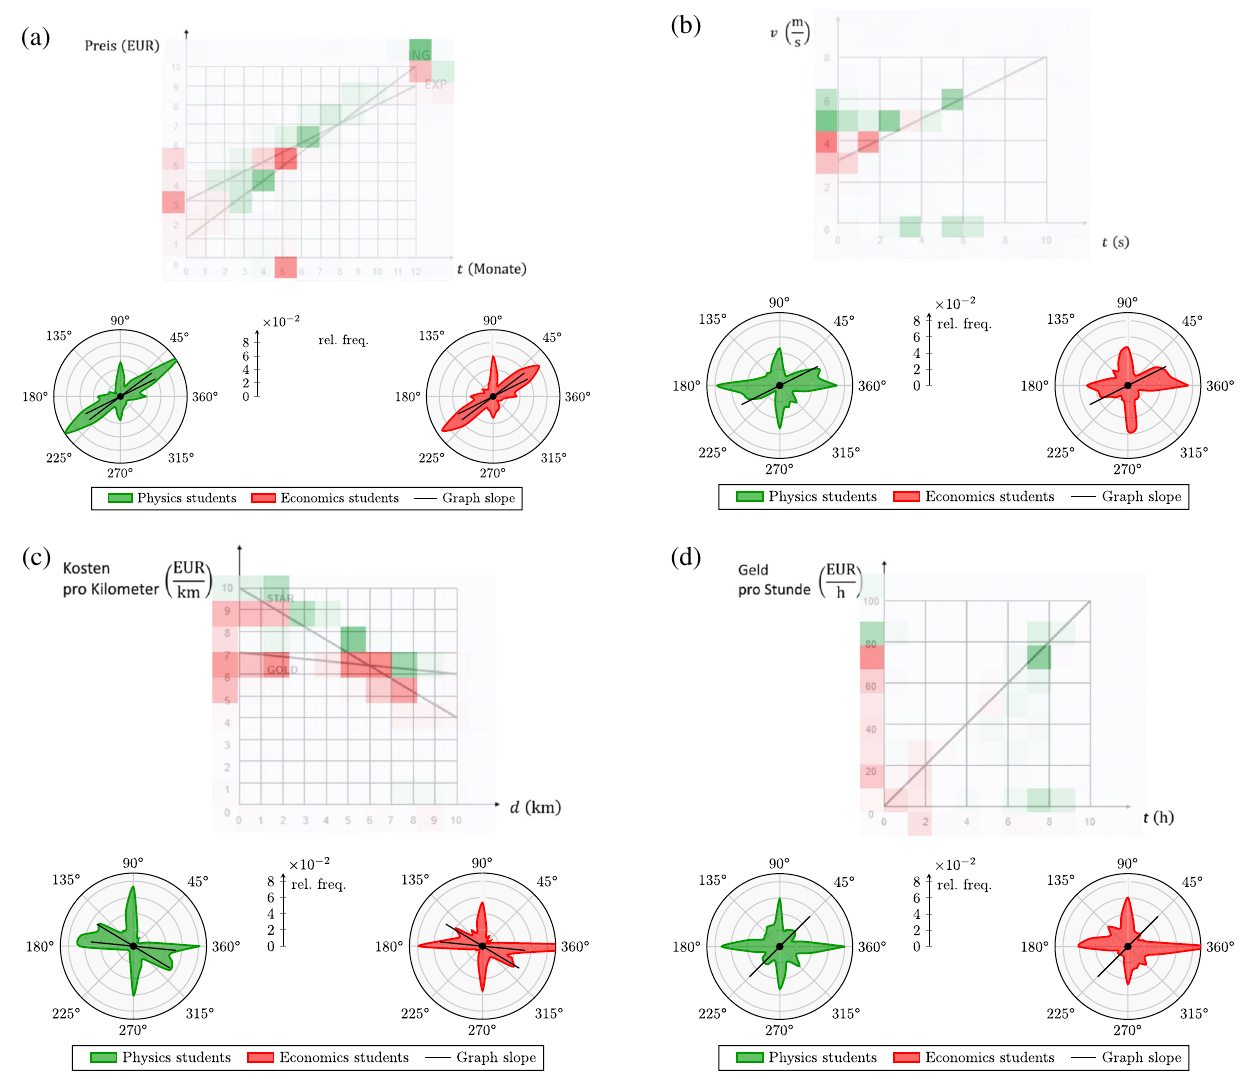
FIG. 14. Analysis of visual attention and saccadic directions for (a) the qualitative question on graph slope in the context of finance, for (b) the quantitative question on graph slope in the context of physics, for (c) the qualitative question on area under a curve in the context of finance, and for (d) the quantitative question on area under a curve in the context of finance. The green (red) color indicates areas that were observed significantly longer by physics (economics) students. In (a), students had to compare price rates of two objects within the first five months of a time period. In (b), students had to determine the acceleration from the graph. In (c), students had to compare the total costs for a taxi ride (8 km) between two companies. In (d), students had to calculate from the diagram the total salary of a worker after working 8 hours. TABLE III. Results of the two-way ANOVAs conducted on students ’ confidence ratings with the context (physics vs finance) as a within-subject factor and with the group (physics students vs economics students) as a between-subject factor. Group Context Interaction F p η 2 F p η 2 F p η 2 p p p Slope qualitative 0.70 > 0 . 05 (cid:3) (cid:3) (cid:3) 0.14 > 0 . 05 (cid:3) (cid:3) (cid:3) 0.97 > 0 . 05 (cid:3) (cid:3) (cid:3) Slope quantitative 0.90 > 0 . 05 (cid:3) (cid:3) (cid:3) 0.04 > 0 . 05 (cid:3) (cid:3) (cid:3) 0.50 > 0 . 05 (cid:3) (cid:3) (cid:3) Area qualitative 2.11 > 0 . 05 (cid:3) (cid:3) (cid:3) 0.06 > 0 . 05 (cid:3) (cid:3) (cid:3) 0.25 > 0 . 05 (cid:3) (cid:3) (cid:3) Area quantitative 0.51 > 0 . 05 (cid:3) (cid:3) (cid:3) 0.02 > 0 . 05 (cid:3) (cid:3) (cid:3) 2.00 > 0 . 05 (cid:3) (cid:3) (cid:3)